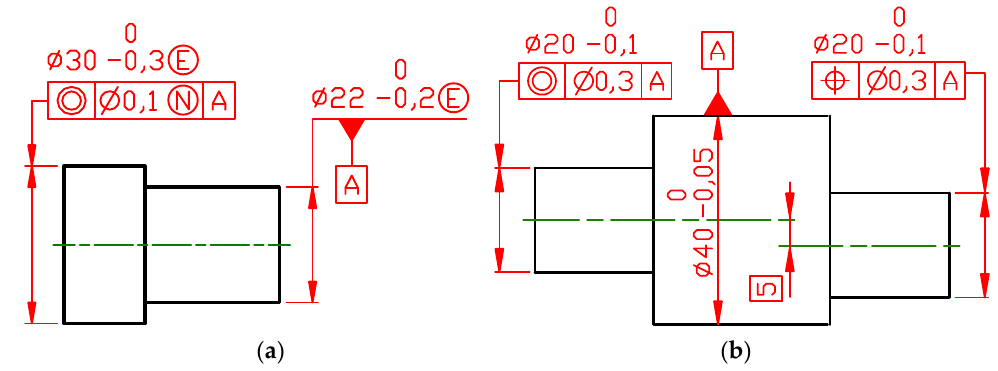
Figure 12. ( a ) Coaxiality tolerance for flange with respect to datum axis A (ISO GPS), equivalent to the specification given in Figure 11a; ( b ) for coaxiality tolerance, TED = 0 mm is obvious. If the offset between the axes in a complex part will be significantly smaller, there is a risk for the position tolerance that a drawing reader will not detect such offset.